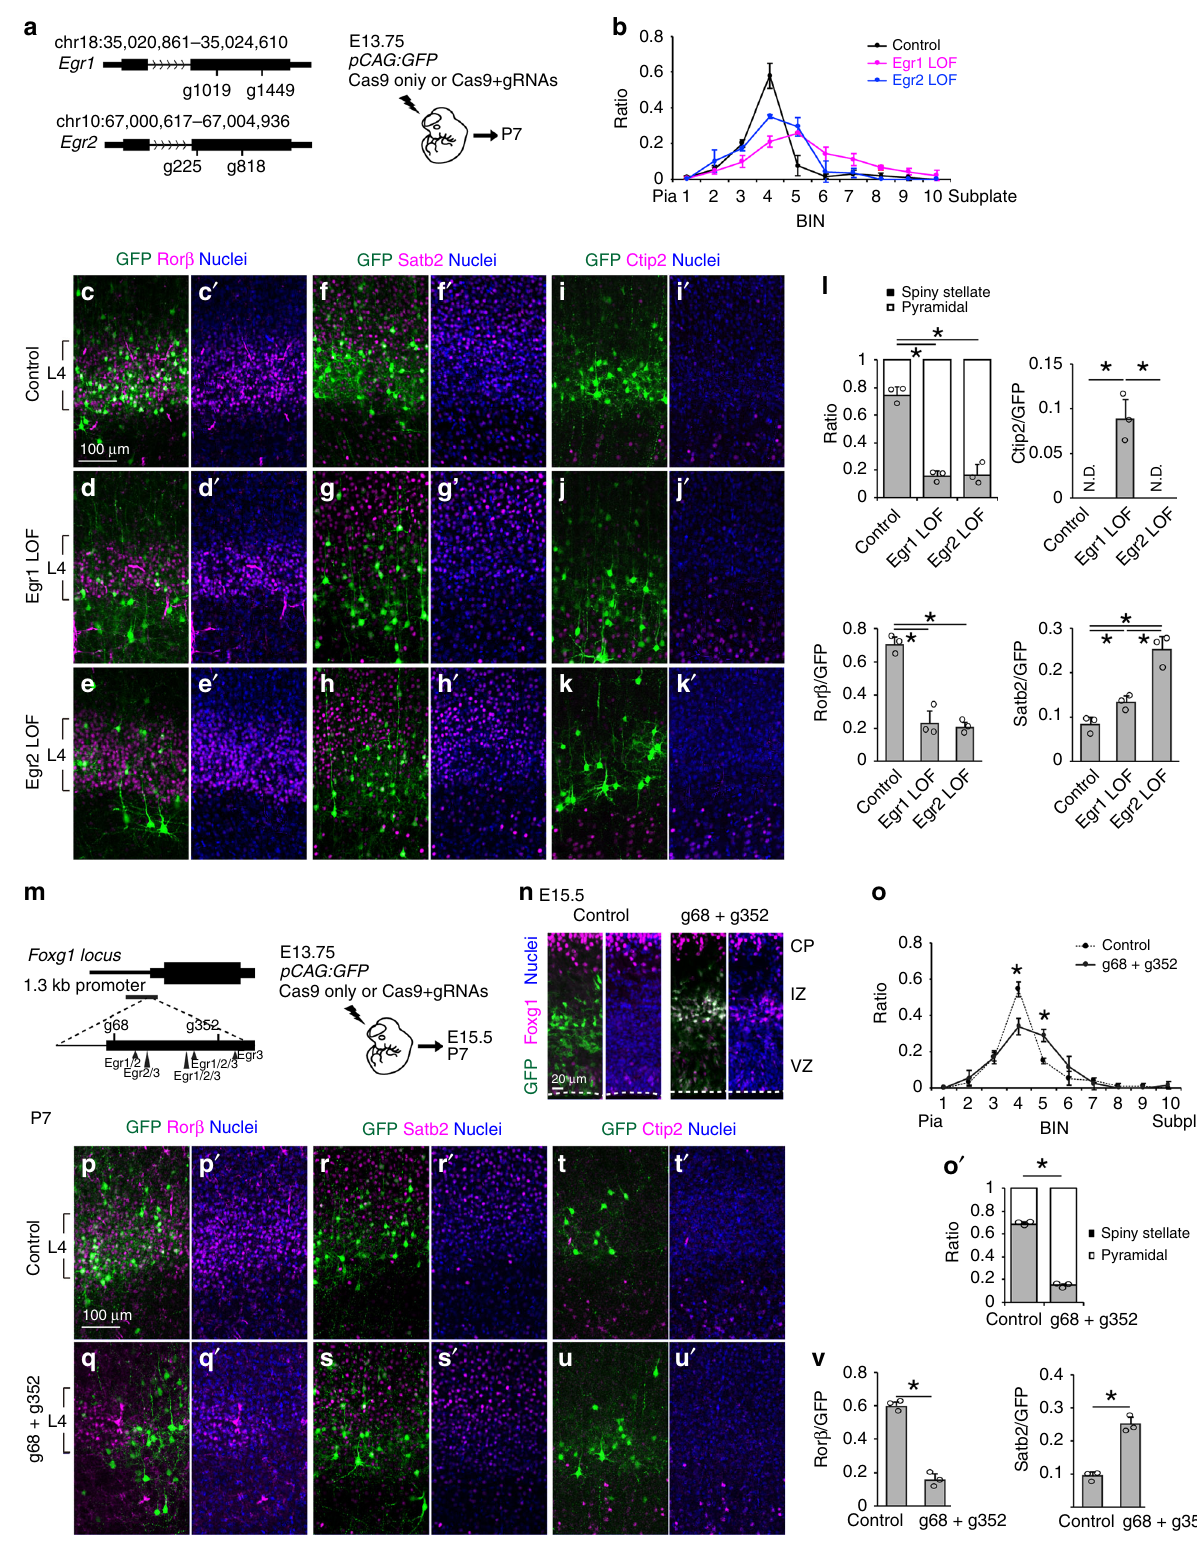
Immunohistochemistry and image acquisition . Embryonic brains up to E17.5 were collected directly, and brains from embryos >E17.5 and postnatal stages were perfused with PBS and 4% paraformaldehyde (PFA) prior to fi xation. Embryonic brains were fi xed with 4% PFA at 4 °C for 1h, and postnatal brains were fi xed with 2% PFA overnight. For cryosection, brains were immersed in 30% sucrose – PBS at 4 °C overnight and embedded in Tissue-Tek O.C.T compound (Sakura).